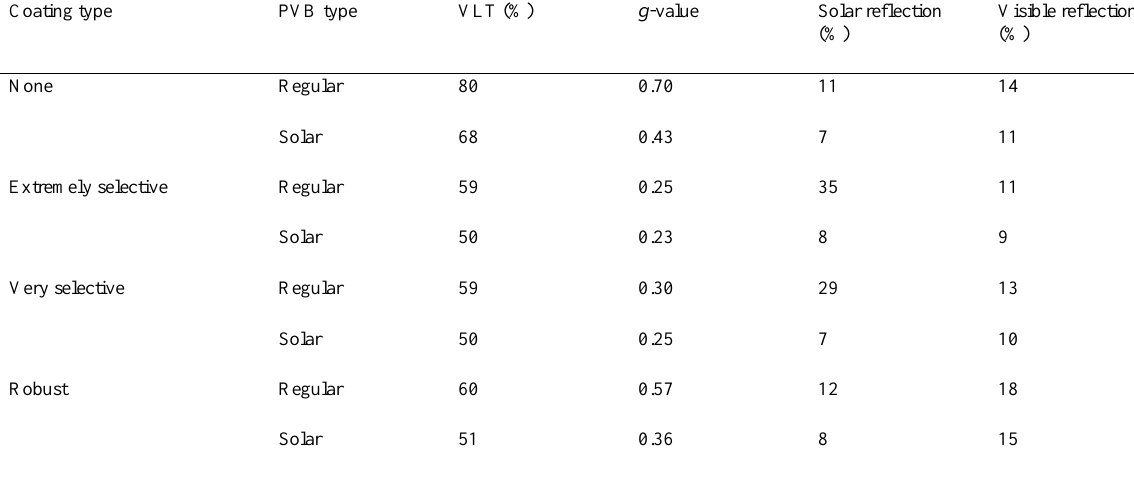
Table 2. Performance of solar PVB in different coated IGU types